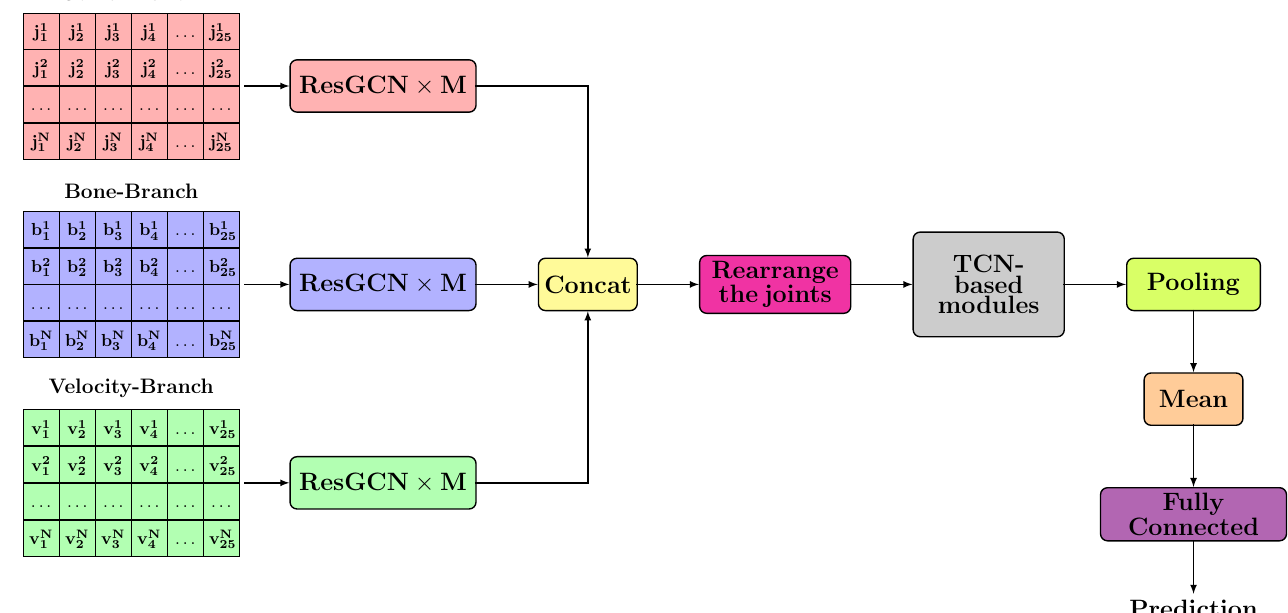
Figure 6. The proposed general architecture for Temporal Convolutional Network (TCN)-based